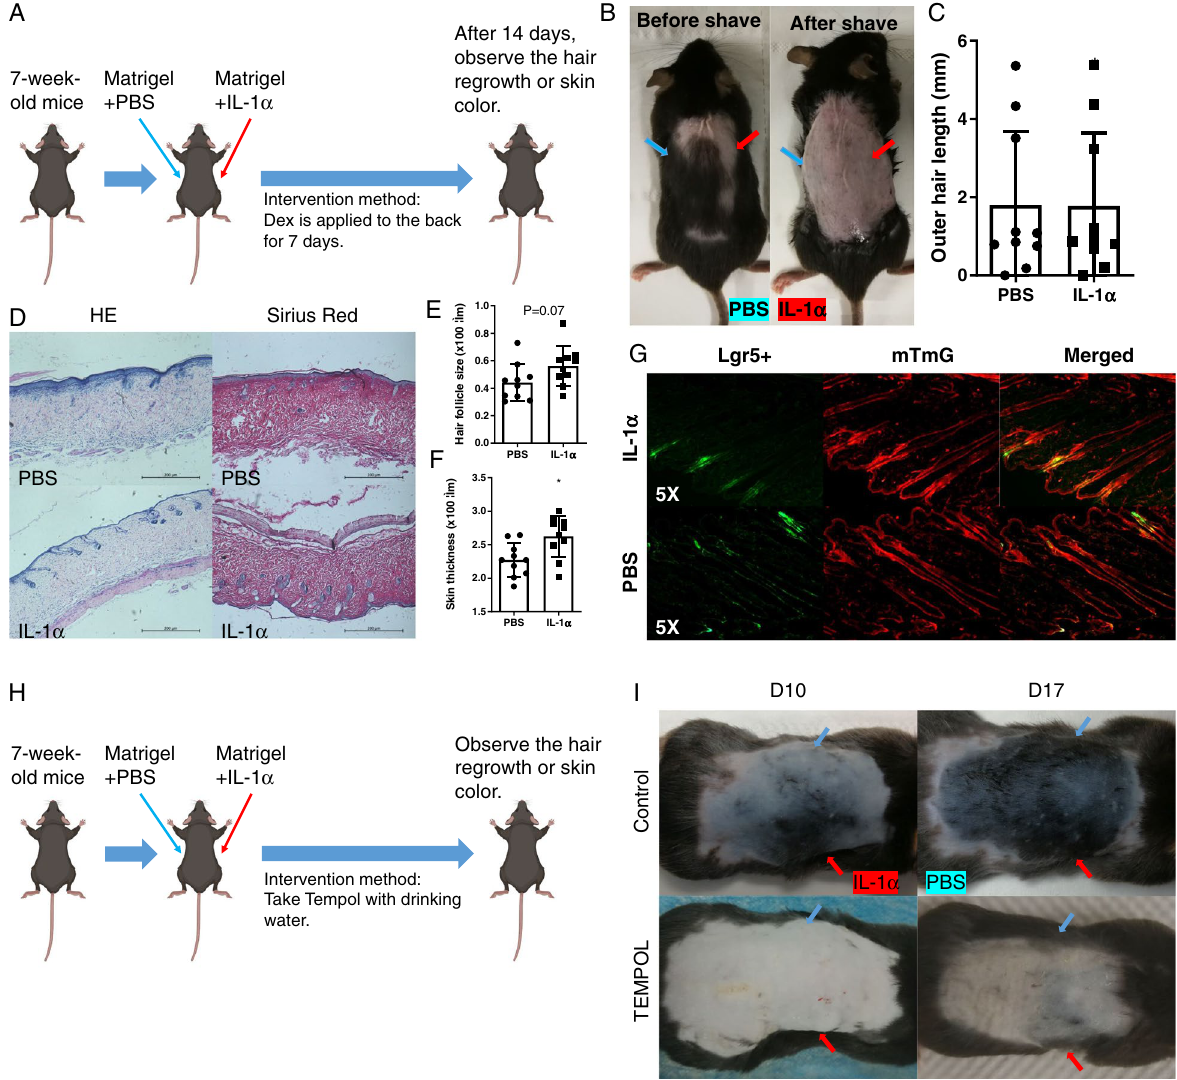
Fig. 8 Dexamethasone and TEMPOL reduced IL-1α-induced effects in 7W mice. A Experimental steps. B Representative photos of mice on the 14th day after dexamethasone treatment. Blue arrows direct the PBS area, and red arrows direct the IL-1α area. C IL-1α failed to increase the outer hair length under the treatment of dexamethasone (PBS vs IL-1α, 1.796 Red staining from the same mouse. E IL-1α did not increase HFs size (PBS vs IL-1α, 0.4420 skin thickness (PBS vs IL-1α, 2.272 TEMPOL delayed IL-1α-induced hair regrowth. * P < 0.05, ** P <